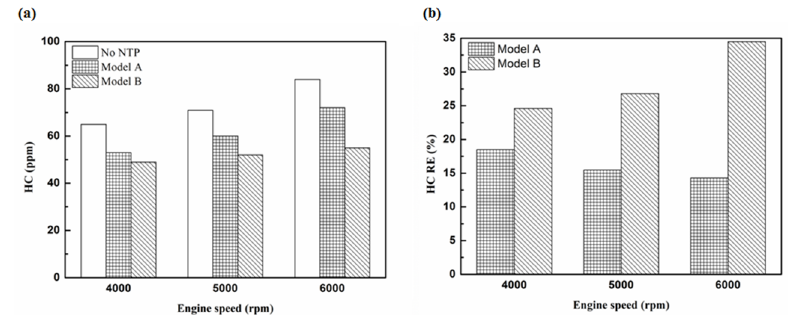
Figure 10. The HC ( a ) emission values and ( b ) RE of control voltage 5 V using iridium alloy.